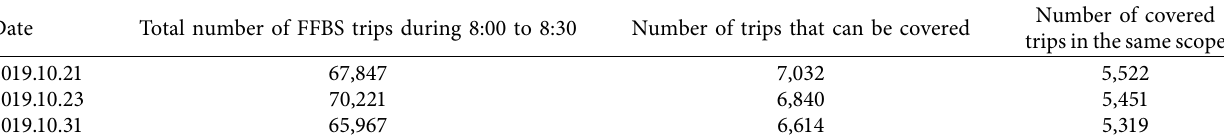
Table 7: Verifcation result of FFBS trips covered by the generated service